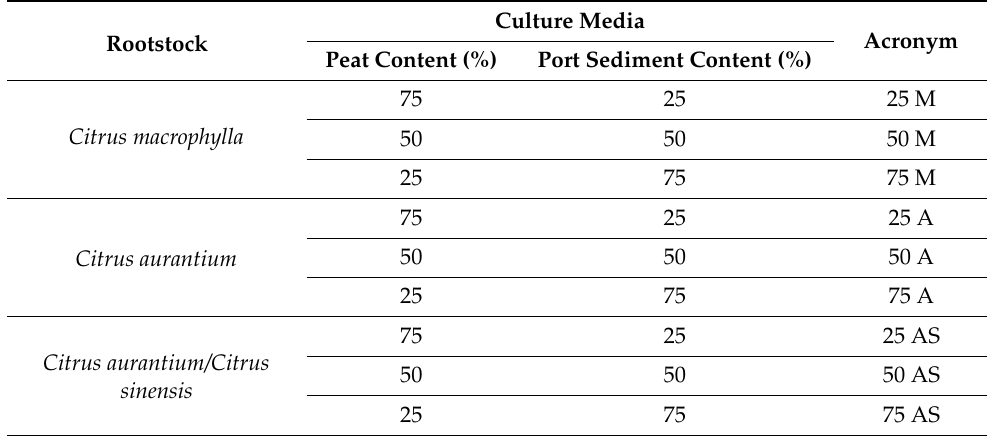
Table 1. Specifications of the rootstock and the culture medium of the lemon fruits evaluated in this study, with emphasis on the acronym